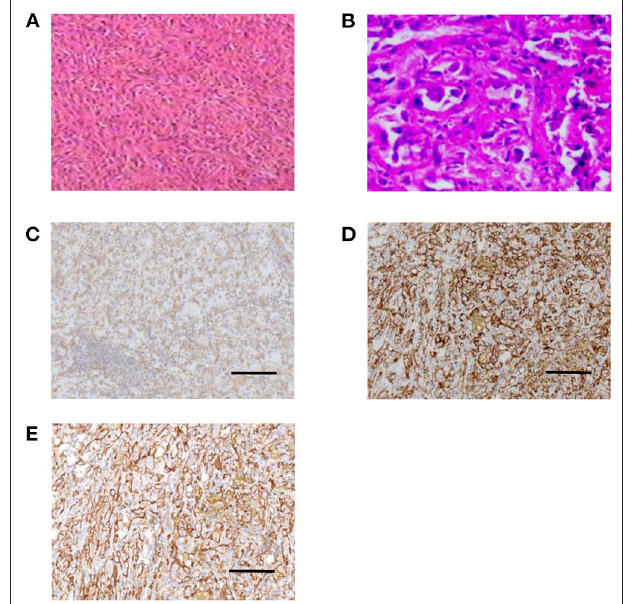
FIGURE 2 | Pathology of a 49-year-old female patient with mediastinal EHE at the first treatment. (A) Histology showed that the tumour was composed of epithelioid cells and fusiform cells (HE, × 200). (B) Small focal necrosis and tumour thrombi in the vessels and nuclear division were observed (HE, × 400). (C–E) Immunohistochemistry showing tumour cells positive for CD34 (C) , CD31 (D) , and vimentin (E) , scale bar = 200 µ